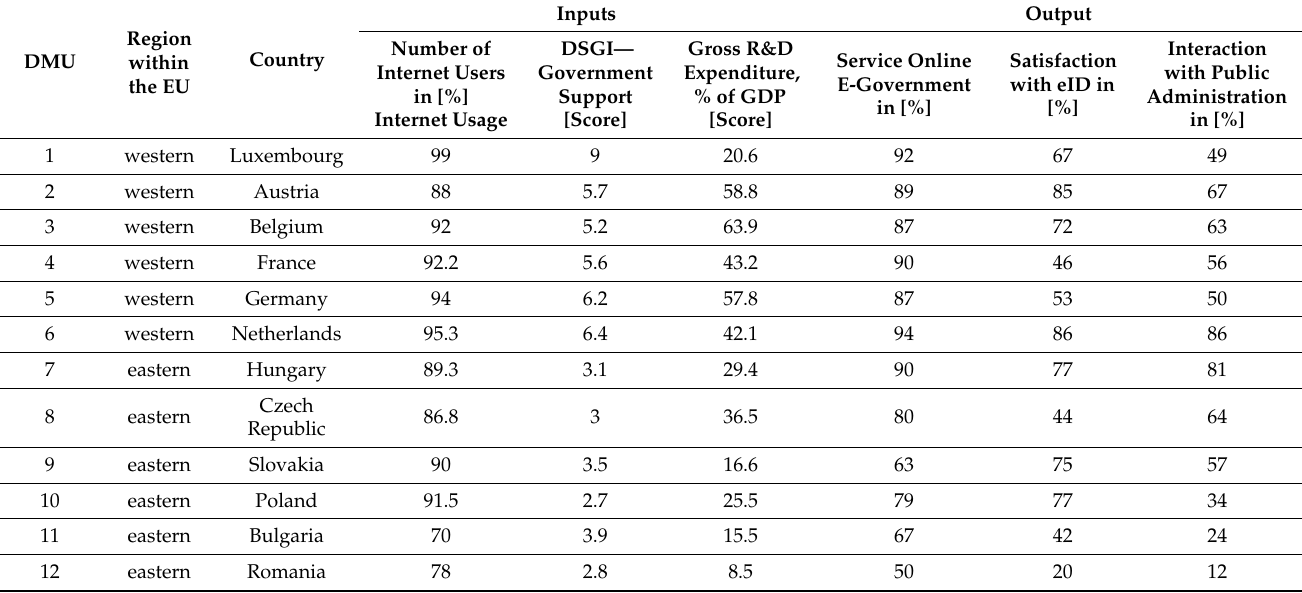
Table 9. Inputs and outputs data for the DEA